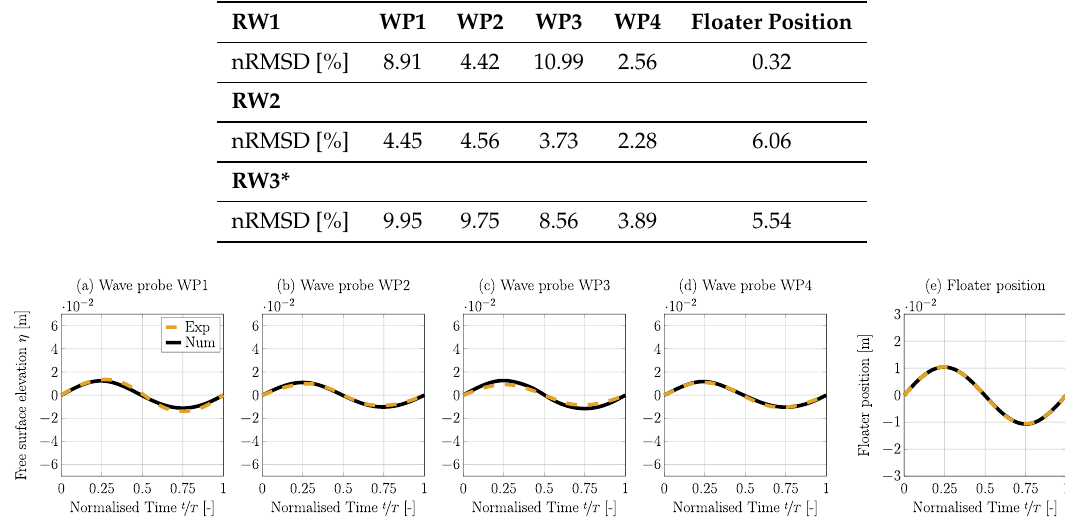
Figure 21. Phase-averaged free surface elevation, measured at wave probes WP1–WP4 ( a – d ), and floater position ( e ) for wave RW1.